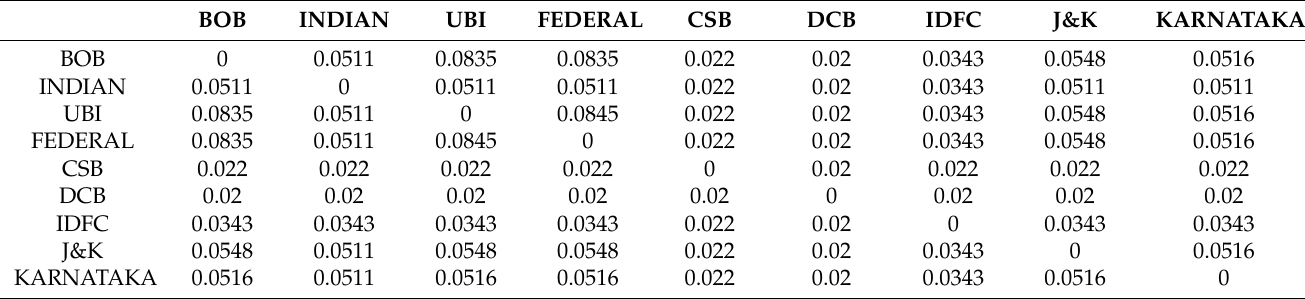
Table 12. Adjacency matrix of the strength of connectedness (1st component): reduced list of 9 banks.